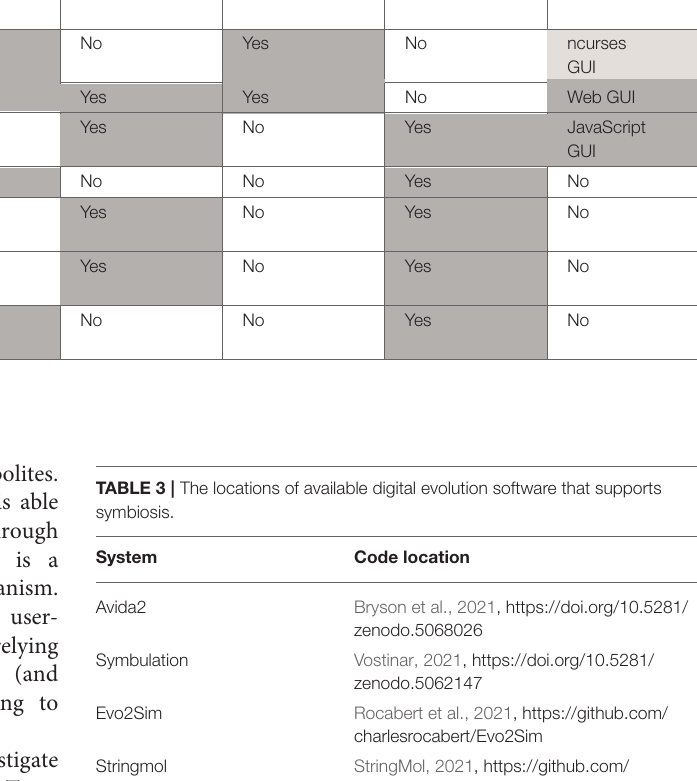
TABLE 2 | A comparison of the digital evolution software systems used in the work reviewed in section 6. System Code available (Locations in Table 3)